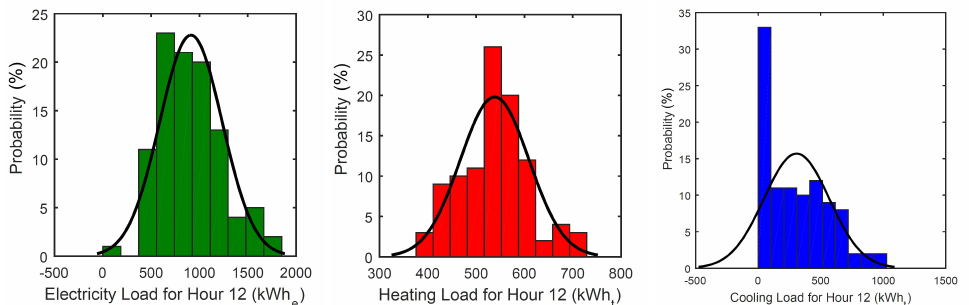
Figure 17. Probability of electricity load ( left ), heating ( center ), and cooling load ( right ) of the 12th hour on 20 March.